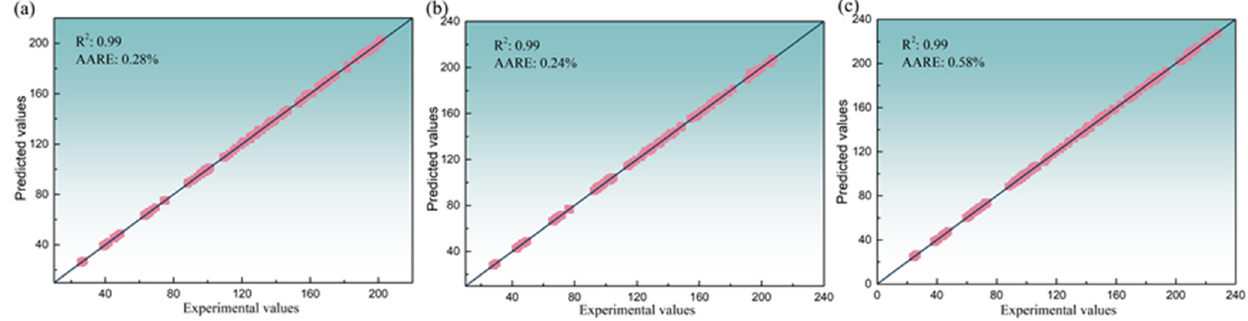
Figure 12. Comparison of experimental and ANN predicted flow stresses ( a ) AA5182, ( b ) AA5182 − 0.05Sc − 0.1Zr, and ( c ) AA5182 − 0.1Sc − 0.1Zr.